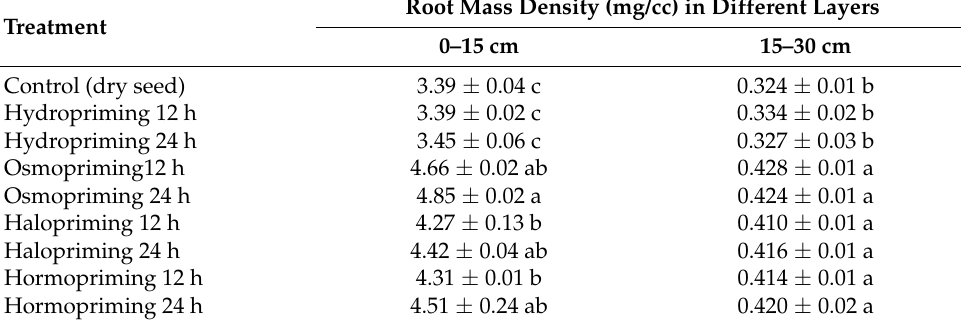
Table 6. Root mass density of rice under different seed priming techniques in conventional DSR establishment method during 2018 at Ludhiana,